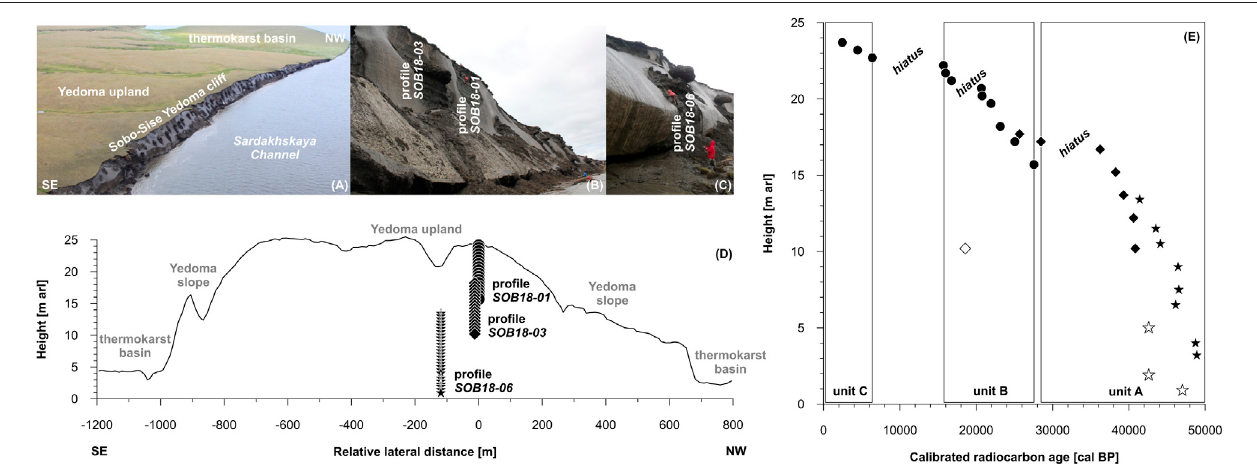
FIGURE 2 | Overview of the sampled pro fi les at Sobo-Sise showing (A) the Yedoma cliff, (B) pro fi les SOB18-01 and SOB18-03, (C) pro fi le SOB18-06, (D) sampling scheme across the Yedoma cliff and (E) age-height relation of the exposure in meter above river level (m arl) and calibrated radiocarbon ages (redrawn from Wetterich et al., 2020). Note the sampling overlap of the pro fi les SOB18-01 (circles), SOB18-03 (diamonds) and SOB18-06 (stars) and their alignment to cryostratigraphic units A, B and C. The hollow symbols indicate ages of re-deposited material or in fi nite radiocarbon ages.